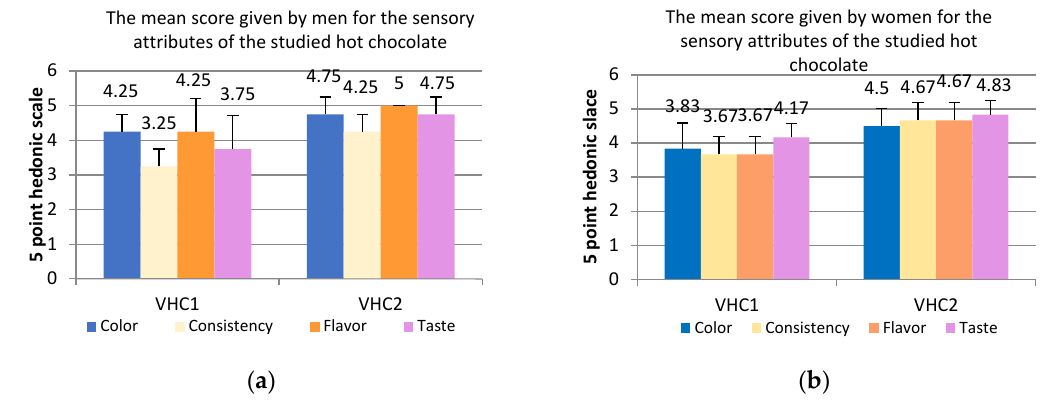
Figure 5. Mean scores of sensory attributes (color; consistency; flavor and taste) for chocolate samples (VHC1 and VHC2) depending on gender (( a ). male; ( b ). women). Women rated the VHC2 sample with highest score for taste (4.83 points), followed by flavor and taste attributes with the same score 4.67 (Figure 5b). The VHC1 chocolate sample was less appreciated